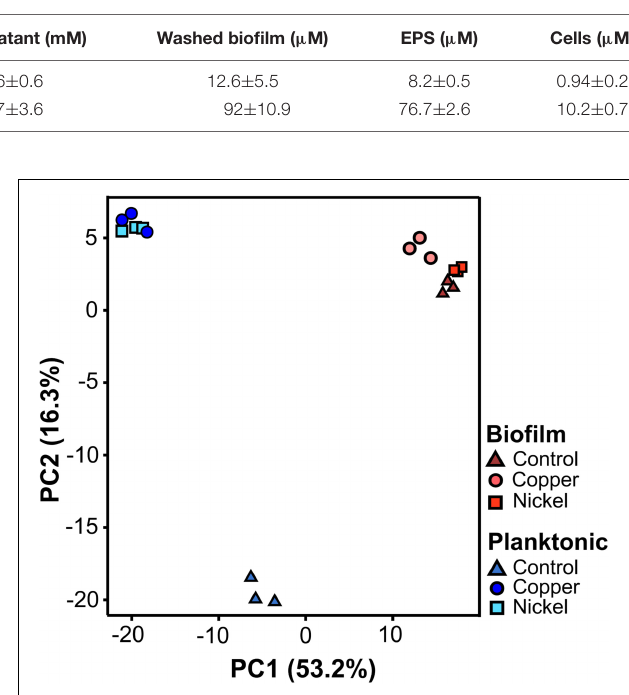
FIGURE 4 | Principal component analysis of the quantitative proteome data sets of planktonic (blue) and biofilm (red) samples. For each physiological state, three independent biological replicates of untreated (triangles), copper (dots), and nickel (squares) treated samples were investigated. Planktonic cells were grown to an optical density of 0.3 and then treated with 5 mM Cu 2 + and 15 mM Ni 2 + for 24 h. Biofilms were grown for 14 days and then incubated with 5 mM Cu 2 + and 40 mM Ni 2 + for another 24